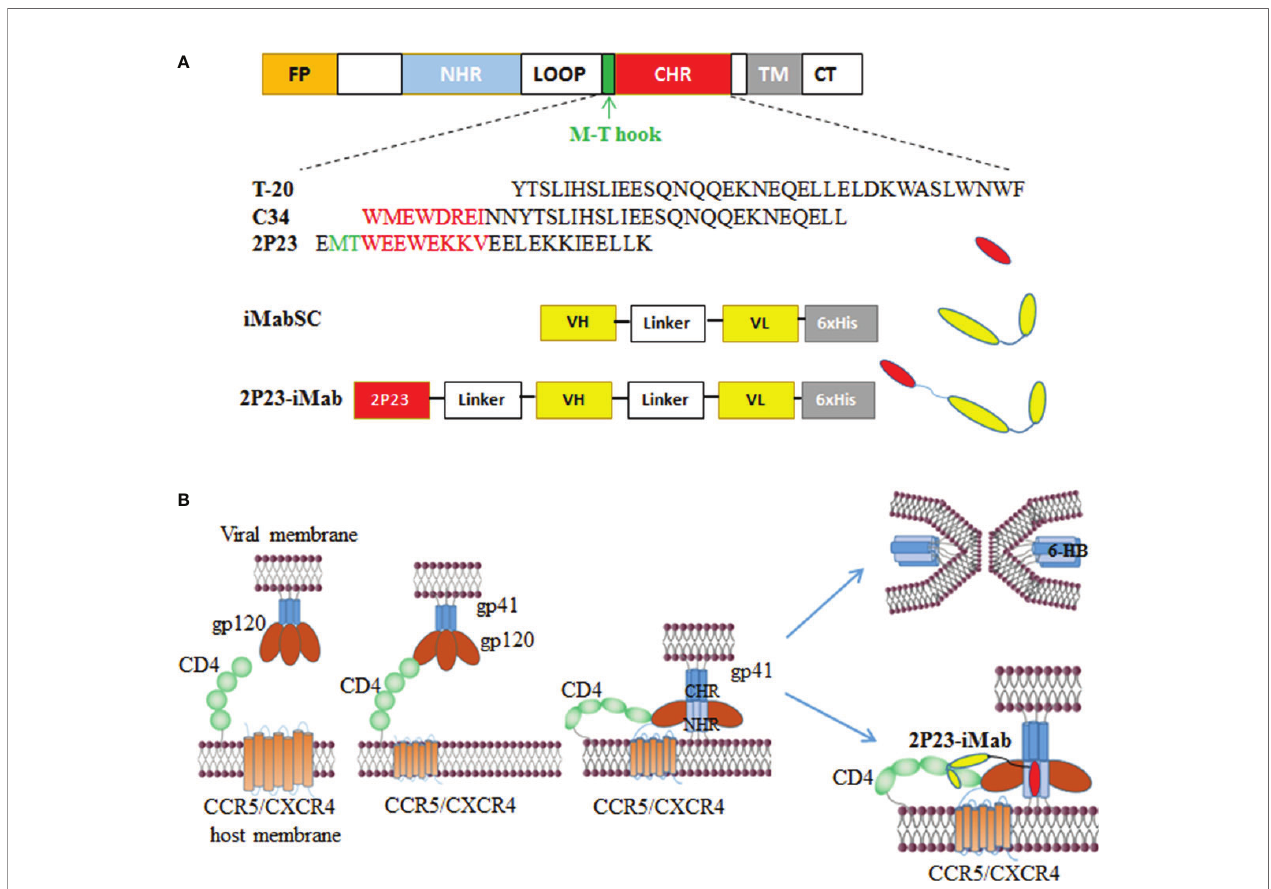
FIGURE 1 | Design of bispeci fi c HIV entry inhibitor 2P23-iMab. (A) Diagram of HIV-1 gp41, CHR-derived fusion inhibitor peptides (T-20, C34, 2P23), and design strategy of 2P23-iMab. FP, fusion peptide; NHR, N-terminal heptad repeat; CHR, C-terminal heptad repeat; TM, transmembrane domain. The pocket-binding sequences on C34 and 2P23 are marked in red. The position and sequence of the M-T hook structure are marked in green. iMabSC represents the single-chain variable fragment (scFv) of ibalizumab with a C-terminal His tag. 2P23-iMab represents a bispeci fi c inhibitor by linking 2P23 to the N terminus of iMabSC. (B) Illustration of HIV-1 entry and action mechanism of 2P23-iMab. Binding of gp120 to the cell receptor CD4 triggers conformational changes of viral Env and further activates the fusion activity of gp41, in which FP inserts the cell membrane and CHR folds onto NHR to form a six-helix bundle (6-HB) that pulls the viral and cell membranes in close apposition for fusion. Sequentially, the binding of 2P23-iMab to CD4 makes the fi rst strike and the binding of 2P23 to the gp41 NHR to make the second attack to the entrance of